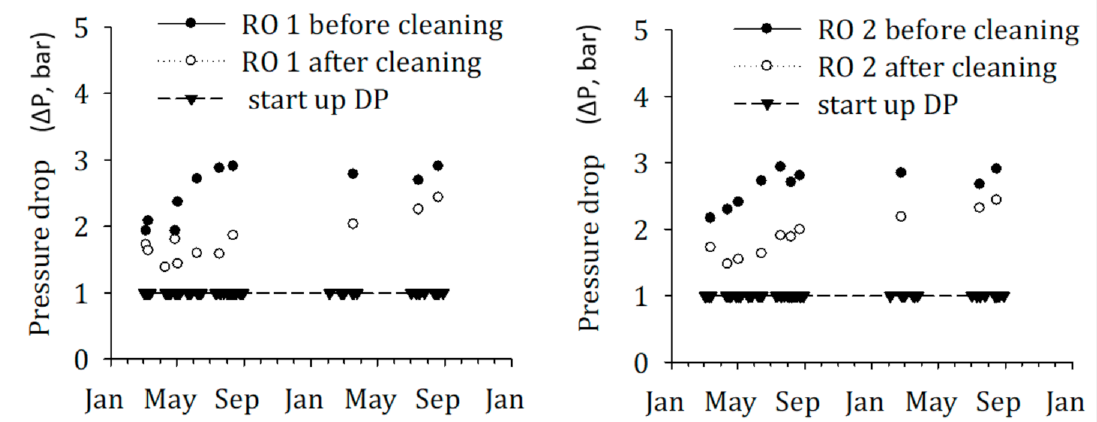
Figure 8. Historical (2015–2016), operational data for pressure drop ( ∆ P) in RO before and after